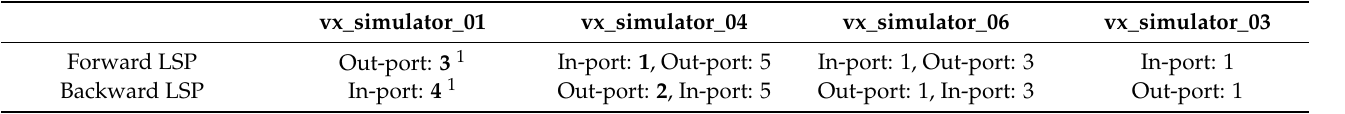
Table 3. A Bi-directional label switching path between node vx_simulator_01 (SCID 1) and node